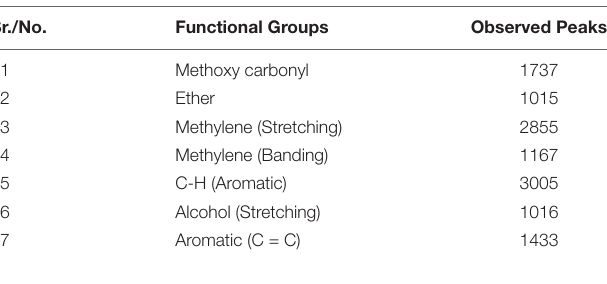
TABLE 2 | List of Functional Groups Observed in Energy Crop Cocklebur Methyl Esters using FT-IR spectroscopy.